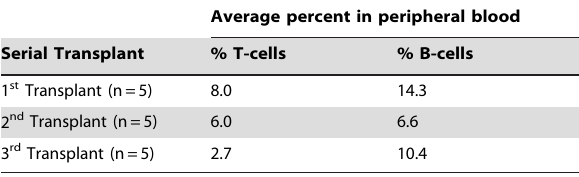
Table 4. Detection of mature murine T and B-cells following serial transplantation of protein treated bone marrow cells in irradiated Rag-1 2 / 2